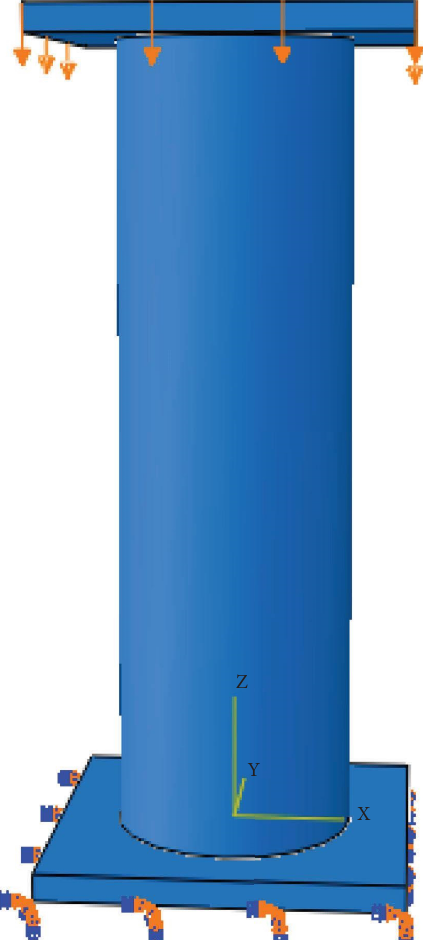
Figure 5: Finite element analysis model.